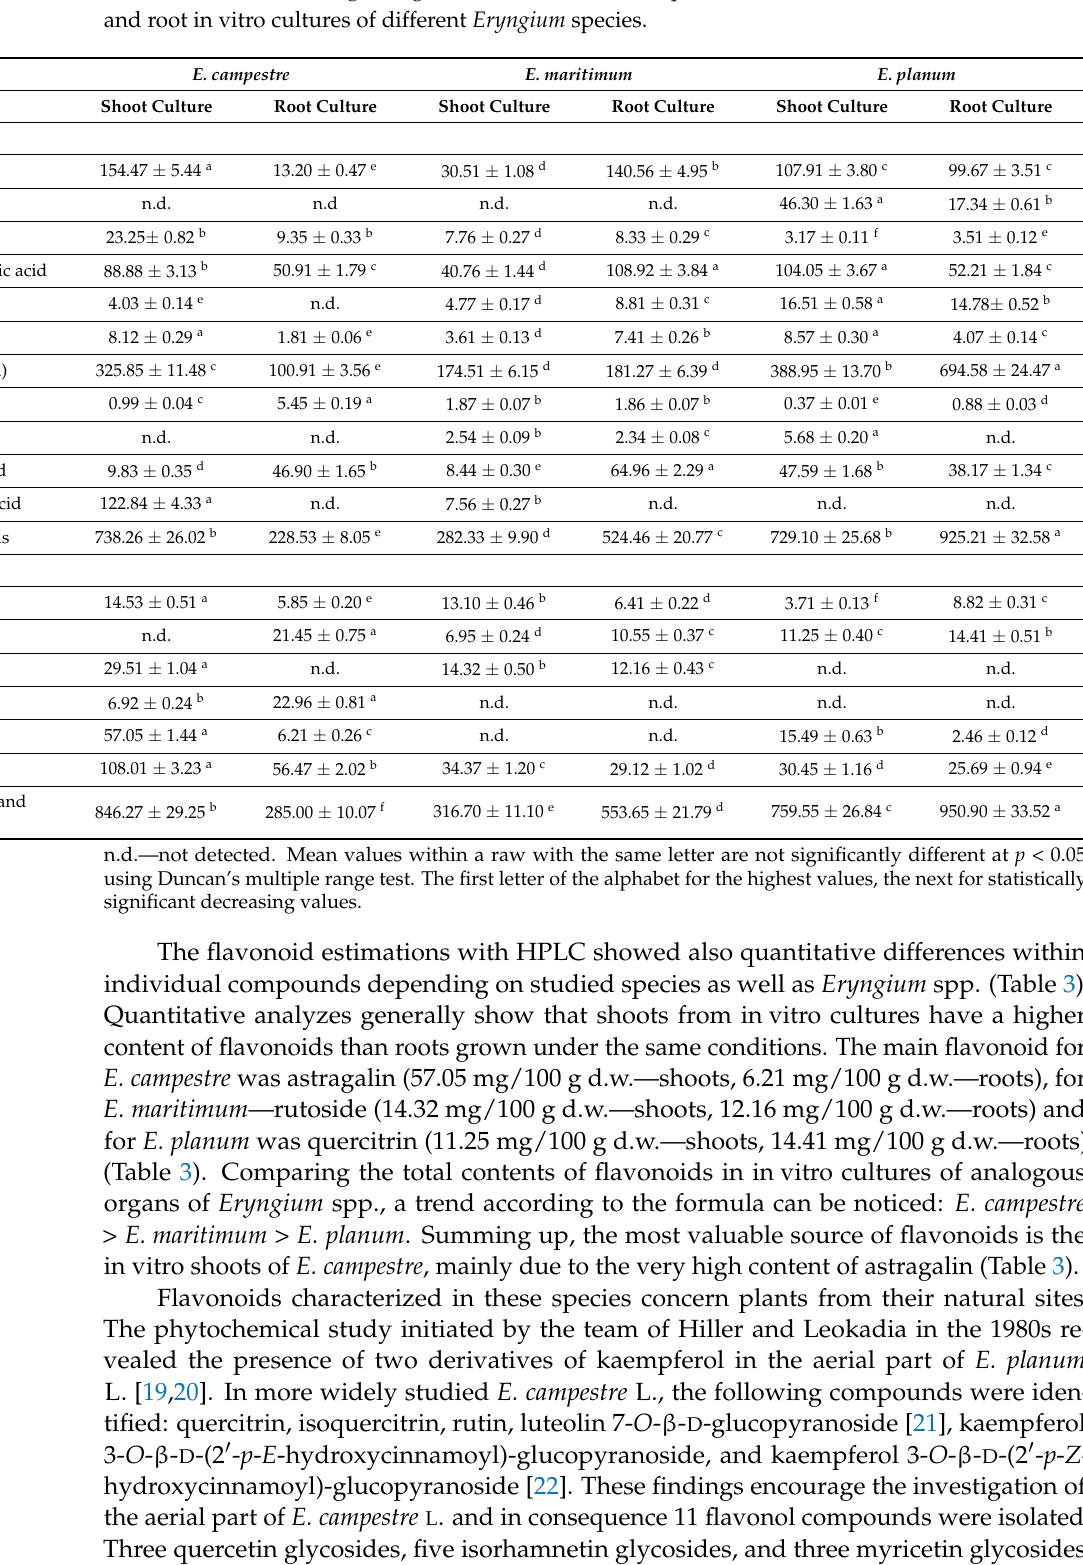
Table 3. The contents (mg/100 g d.w. ± SD) of estimated phenolic acids and flavonoids in the shoot and root in vitro cultures of different Eryngium species.